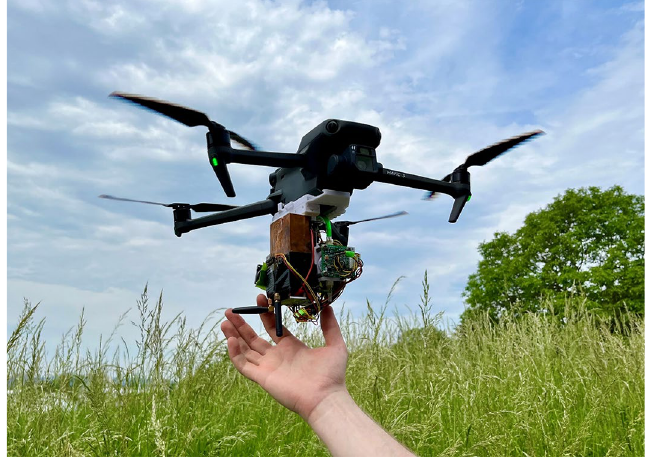
Figure 1. Photo of the observation drone (’little-RAVEN’) during a flight test (Photo taken by T.